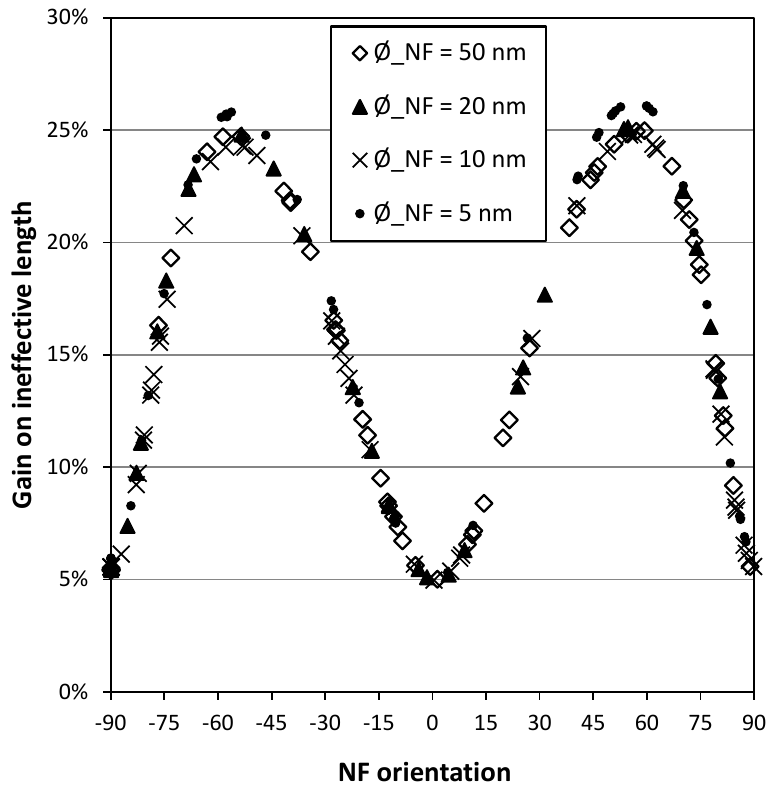
Figure 8. Gain on ineffective length as a function of NF orientation with homogenized reinforced matrix and for 𝑉 NF = 15% M⁄